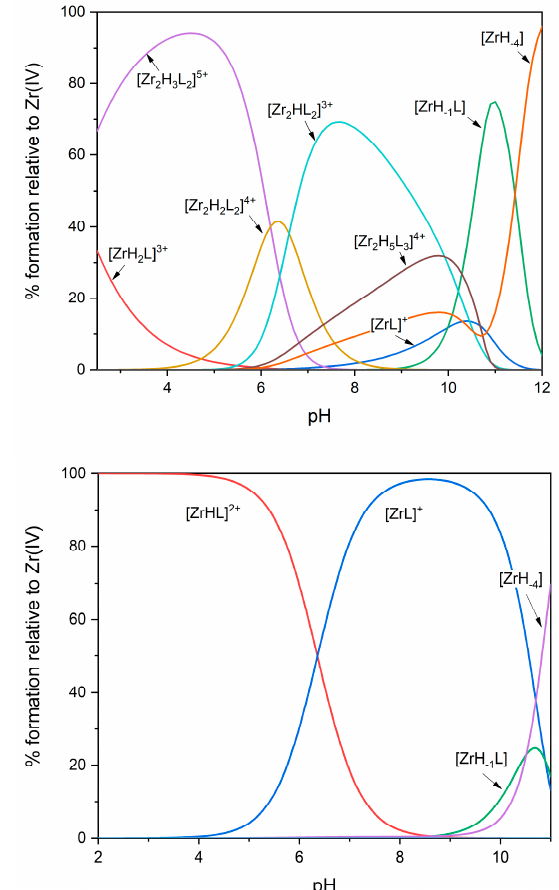
Figure 3. Representative distribution diagrams for the Zr(IV)/DFOB complex-formation equilibria at 25 °C and equimolar concentrations of the metal and the ligand (0.001 mol·dm − 3 ). ( a ) Data from Ref. [12]; ( b ) data from Ref. [13].